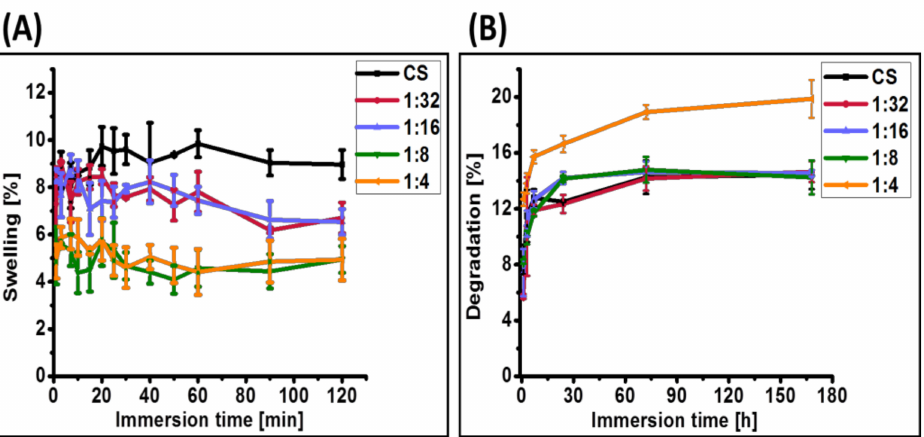
Figure 4. ( A ) Swelling study in PBS and ( B ) degradation study in PBS–lysozyme of CS and Ga (III)-CS complex coatings with di ff erent Ga (III)